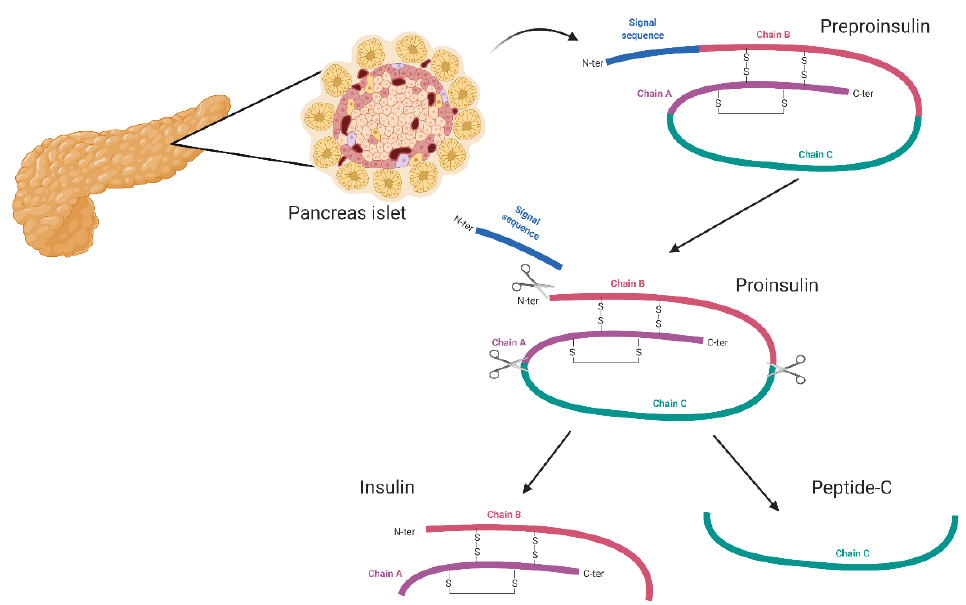
Figure 1. Production of insulin and C-peptide by the pancreatic islets. The diagram shows the processing of pre-proinsulin in the pancreatic islets resulting in the production of insulin and C-peptide. First, the signal sequence (blue) is cut from the primary pre-proinsulin chain, and the molecule is then cut into C-peptide (green) and insulin (pink-purple).